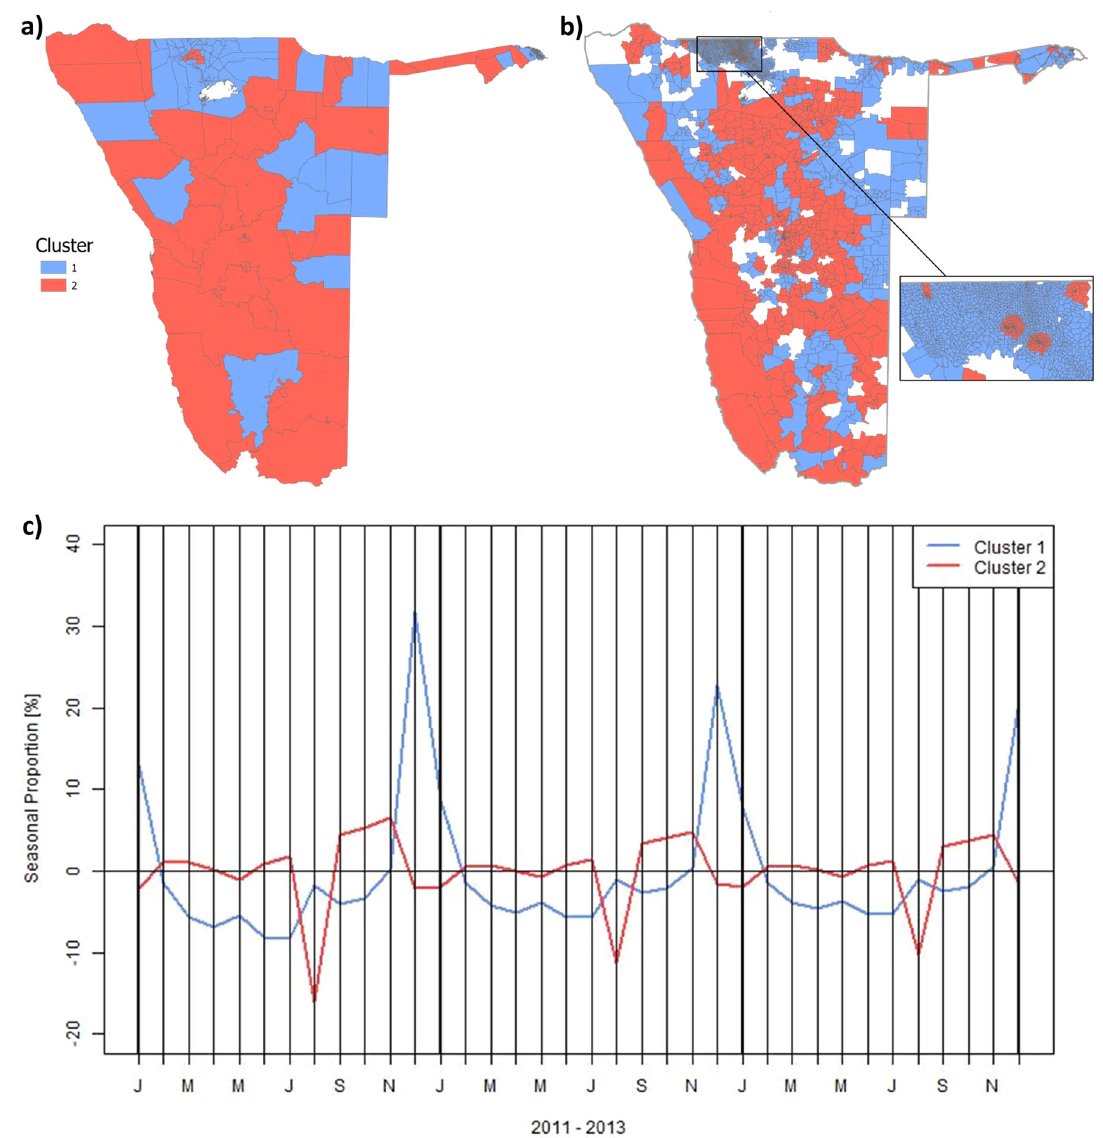
Fig. 6 Grouping of administrative units into two clusters using the Tower Range method. a At level 2, b at level 3, and c average seasonal user proportion per cluster at level 3. Administrative areas without fi ll colour have no